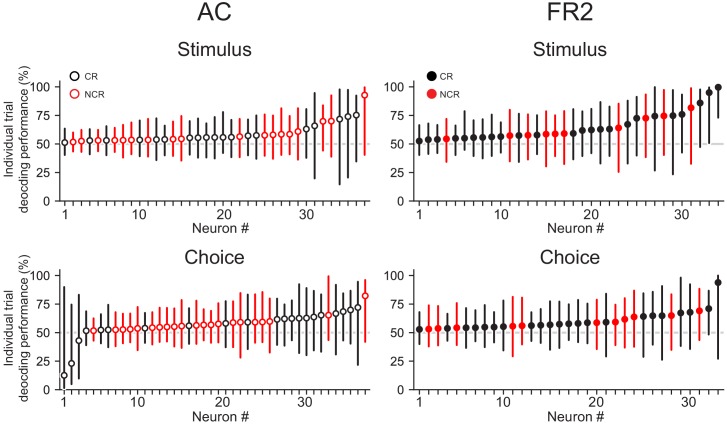
Decoding performance of single cells on individual trials.Median decoding performance on individual trials with error bars denoting top and bottom quartiles. Neurons ordered according to median performance for each region and task variable. Black symbols, classically responsive units; red symbols, non-classically responsive units.